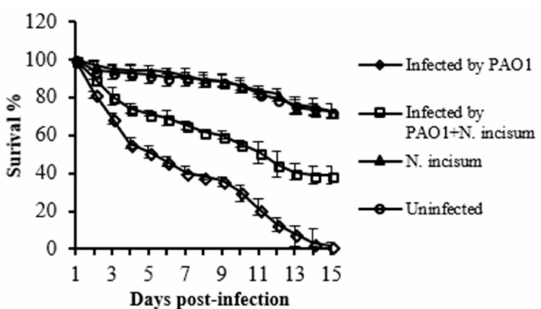
Figure 2. The e ff ect of crude extract from Notopterygium incisum on Drosophila melanogaster infection. The fly feeding assay was used. Survival curves of flies infected with PAO1 alone (diamonds) or together with crude extract (squares) are shown. Uninfected subjects (circles) and feeding with Notopterygium incisum without infection (triangles) were the